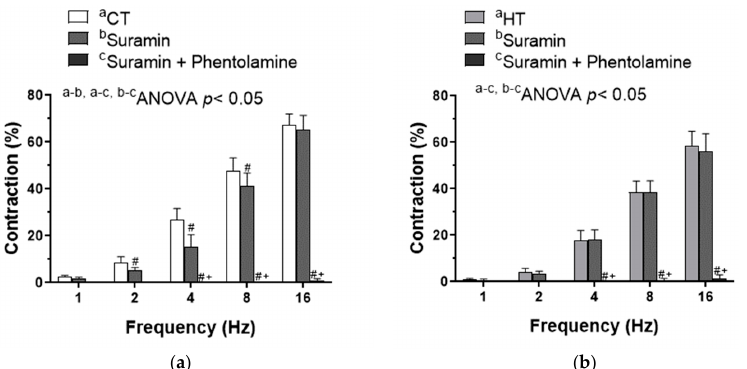
Figure 4. Effect of preincubation with 0.1 mmol/L suramin (antagonist of P2 purinergic receptors) or a combination of phentolamine + suramin on the vasoconstriction response induced by EFS in mesenteric segments from control (CT, ( a )) and rats with hyperthyroidism (HT, ( b )). Results (mean ± S.E.M.) are expressed as a percentage of the initial contraction elicited by KCl. n = 5–6 animals in each group. # p < 0.05 conditions without drug vs. conditions with suramin at each frequency (Bon- ferroni post hoc test). + p < 0.05 conditions without drug vs. conditions with phentolamine + suramin at each frequency (Bonferroni post hoc test).